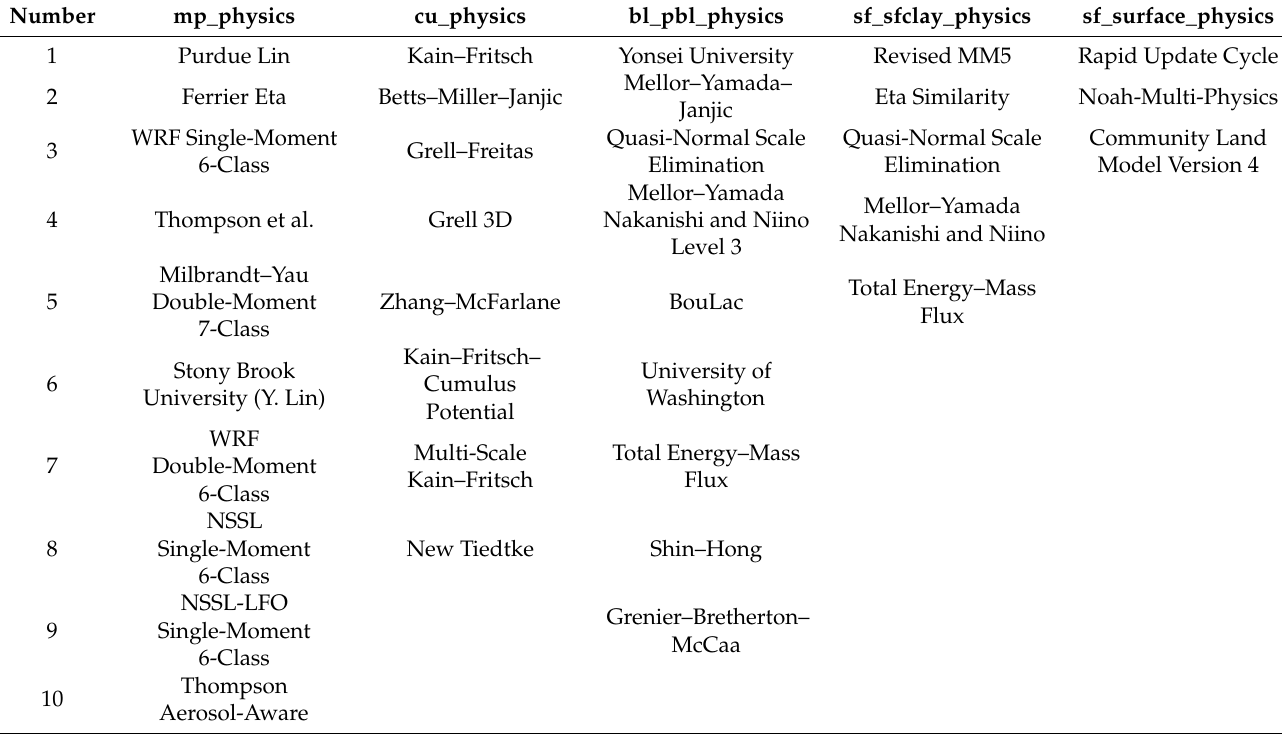
Table 1. The various parameterisation schemes (used in this study) for each of the five physics options in the WRF model: the microphysics parameterisation (mp_physics), cumulus